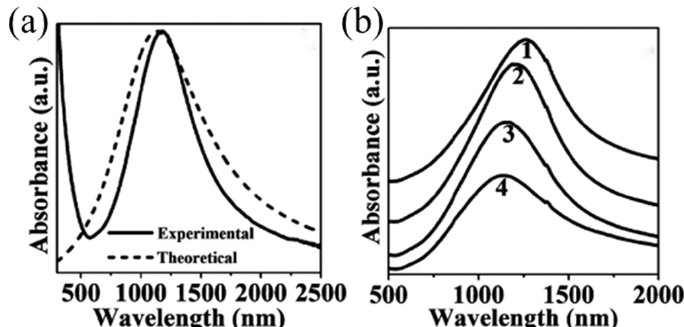
Figure 7. ( a ) Comparison of experimental and theoretical UV-vis-NIR absorption spectra of CuS nanodisks dispersed in tetrachloroethylene. ( b ) LSPR curves (curves 1–4) shift with increasing surface-treatment cycles (Reprinted/adapted with permission from Ref. [53]. Copyright 2013, copyright American Chemical Society).